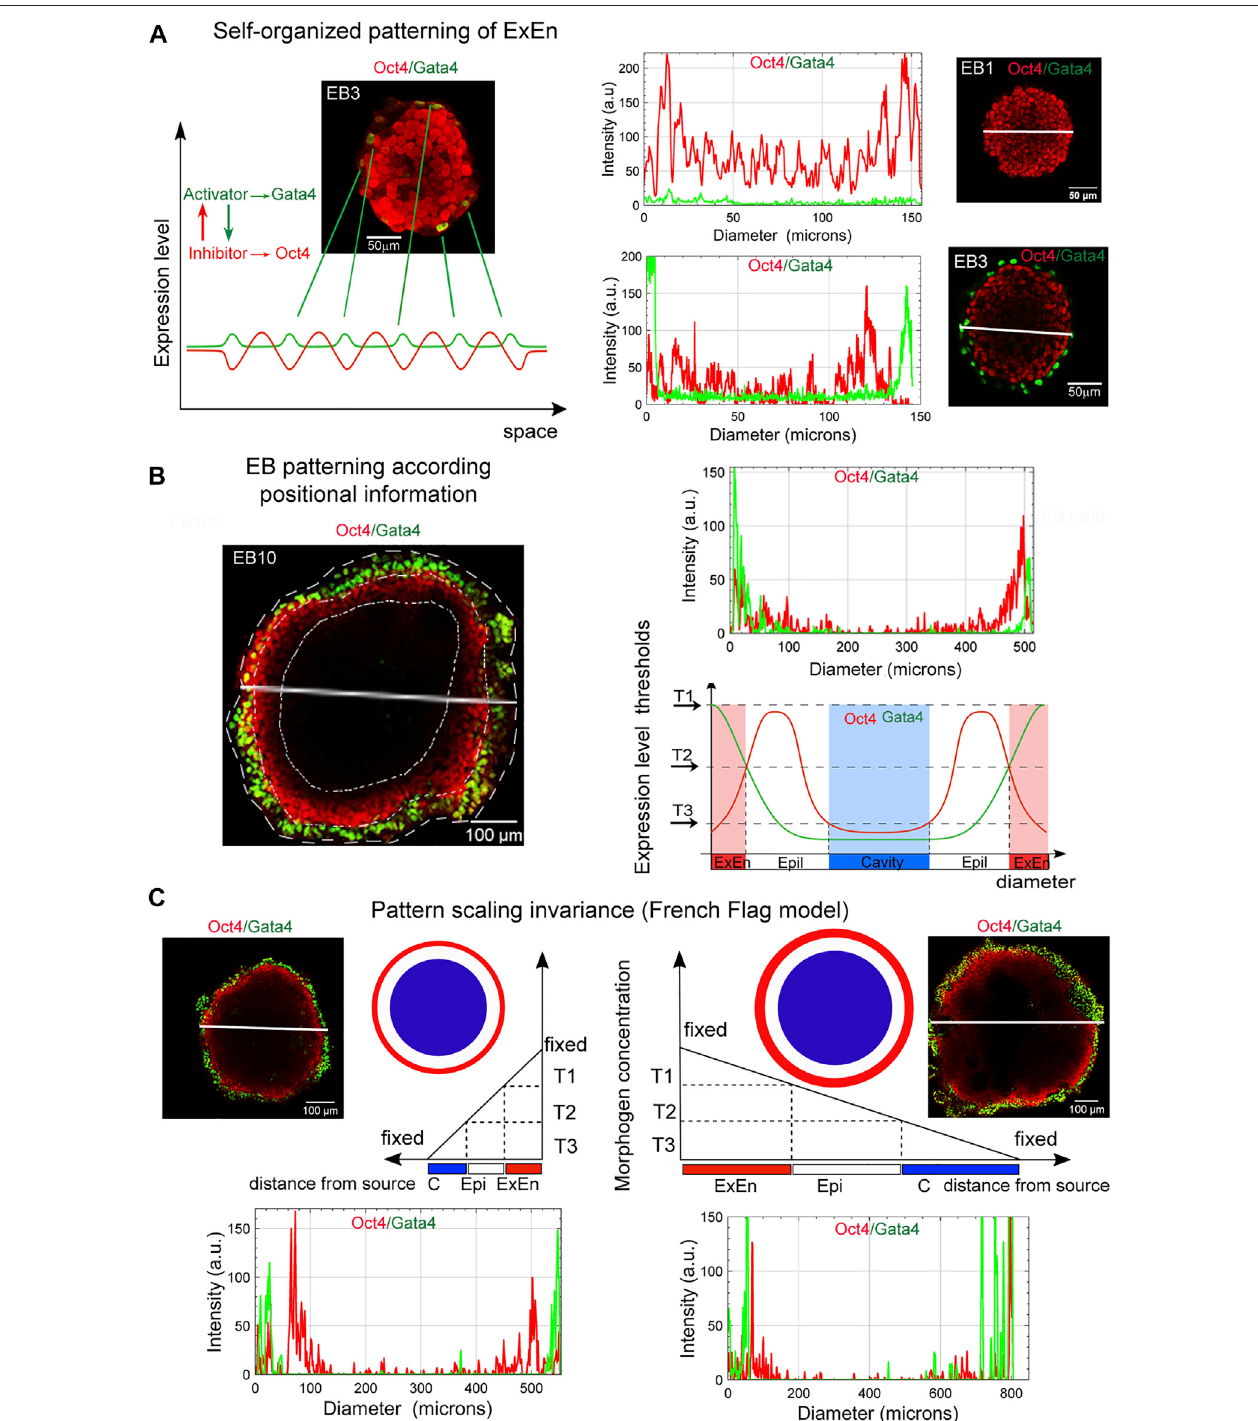
FIGURE9| BasicprinciplesinEBpatterning and scaling. (A) The ExEnpattern inearlyEBscan emergedue torandomchangesintheGata4 and Oct4 expression insurfacecells,whichmaycorrespondtotheRDmodelofself-organizingpatternsinhomogeneoussystems.Representativeplotsofspatialtrendsfortheintensityofthe Oct4 and Gata4 expression across diameters (marked by white lines) in respective images of EB1 and EB3 demonstrate changes in Gata4 expression in surface cell layers.Similar trends insignalintensitychangeswereobservedwhenanalyzing thealongthez-axis (see SupplementaryFigureS7A,B ). (B) Threemorphological patterns in EBs, ExEn, Epi-1, and the cavity, can presumably form in accordance with the position of the cell layers under conditions of a morphogen concentration gradient and free diffusion from the external environment. The EB archetype patterning may be consistent with the French Flag paradigm. The highest morphogens ’